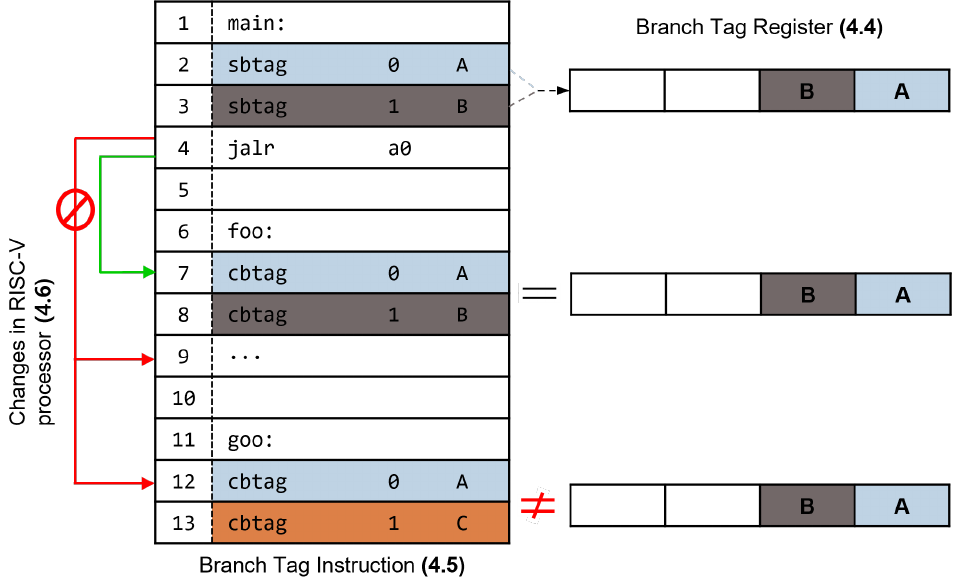
Figure 3. Overview of the Bratter architecture and behavior